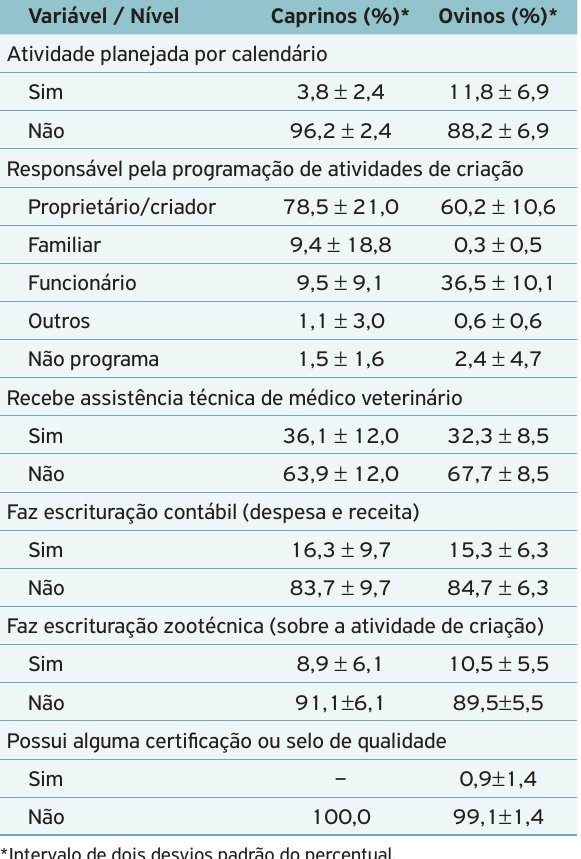
Tabela 7. Caprinocultura e ovinocultura: administração da criação, estado de São Paulo,